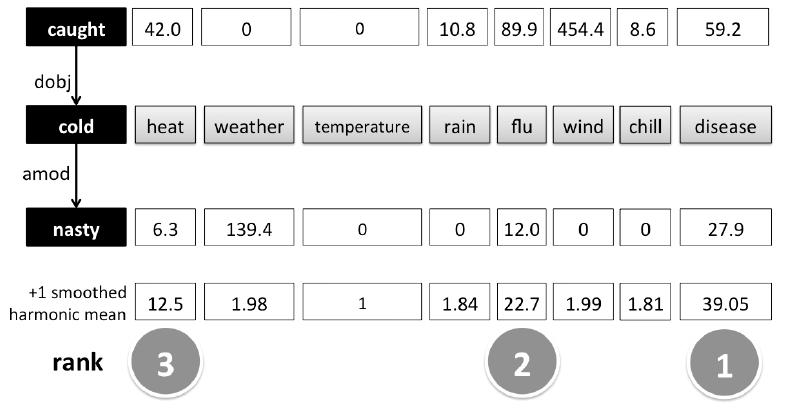
Figure 3: Contextualized ranking for target “cold” in the sentence “I caught a nasty cold” for the 10 most similar terms from the DT (here: 10 million sentences, LMI, p